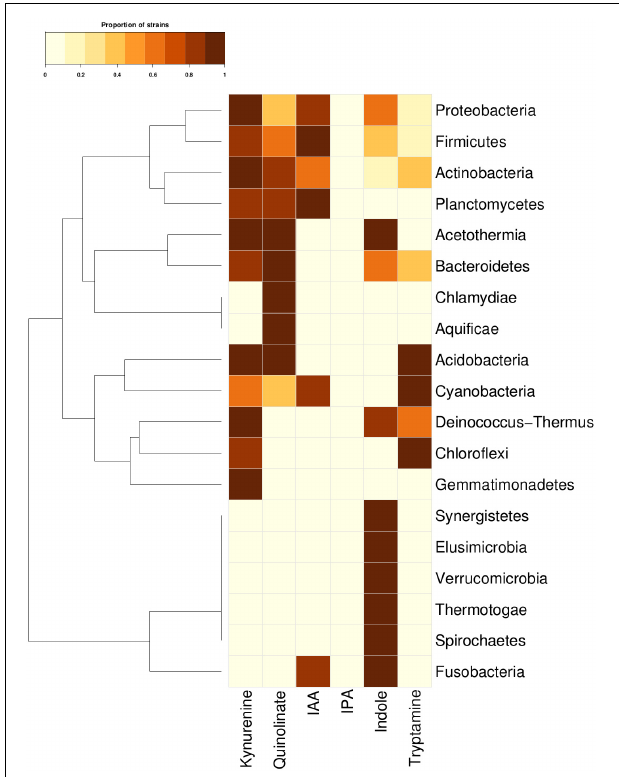
FIGURE 2 | Tryptophan metabolism pathways for neuro-active compound production across bacterial phyla. Distribution of six neuro-active compound production pathways across bacterial phyla comprising of completely sequenced bacterial genomes. Each cell represents the proportion of strains predicted to harbor a pathway for a particular